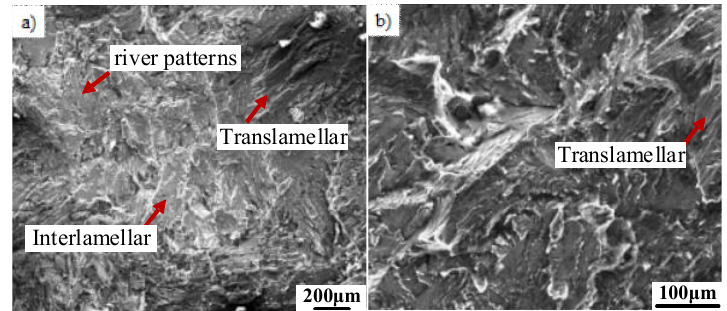
Figure 5. The fracture surface of the as-cast TiAl alloy. ( a ) Interlamellar and translamellar frature, ( b ) translamellar frature.